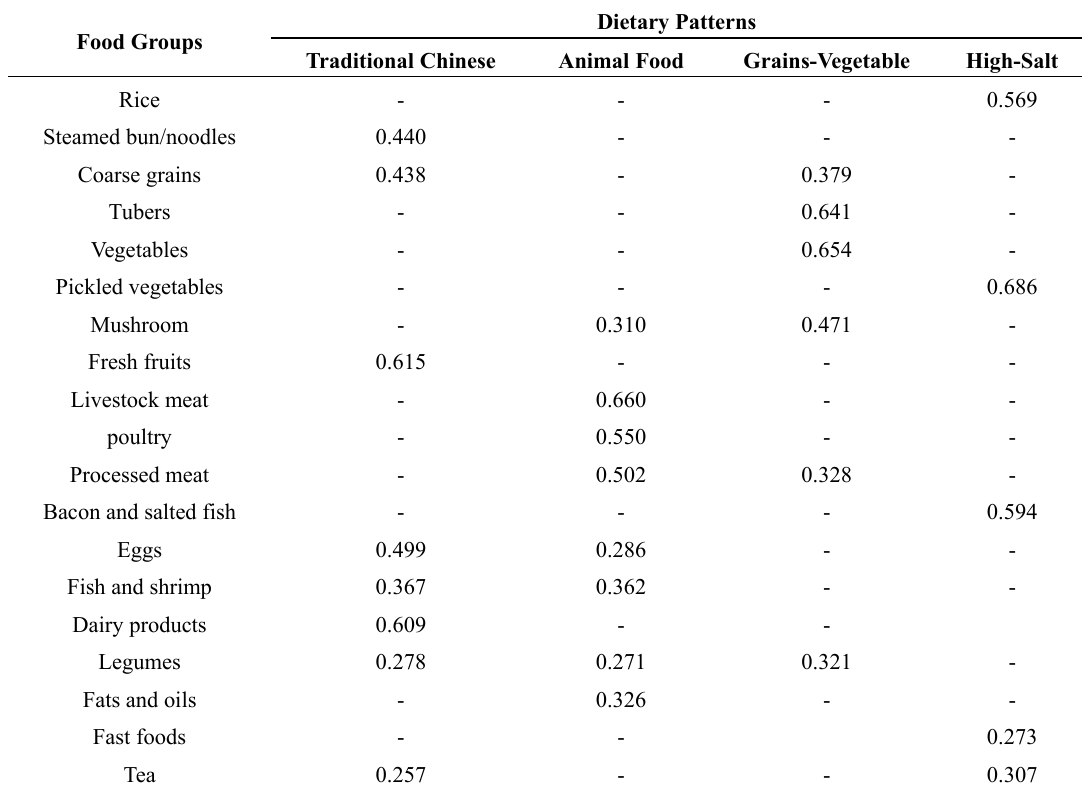
Table 2. Rotated factor loading matrix for the four dietary patterns among 999 Chinese people aged 45–60 years